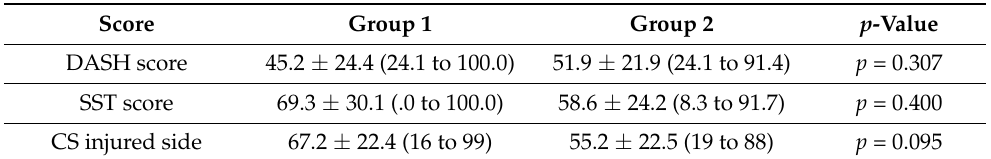
Table 5. Scores comparing group 1 (anatomical/acceptable fracture reduction) and group 2 (malreduction).